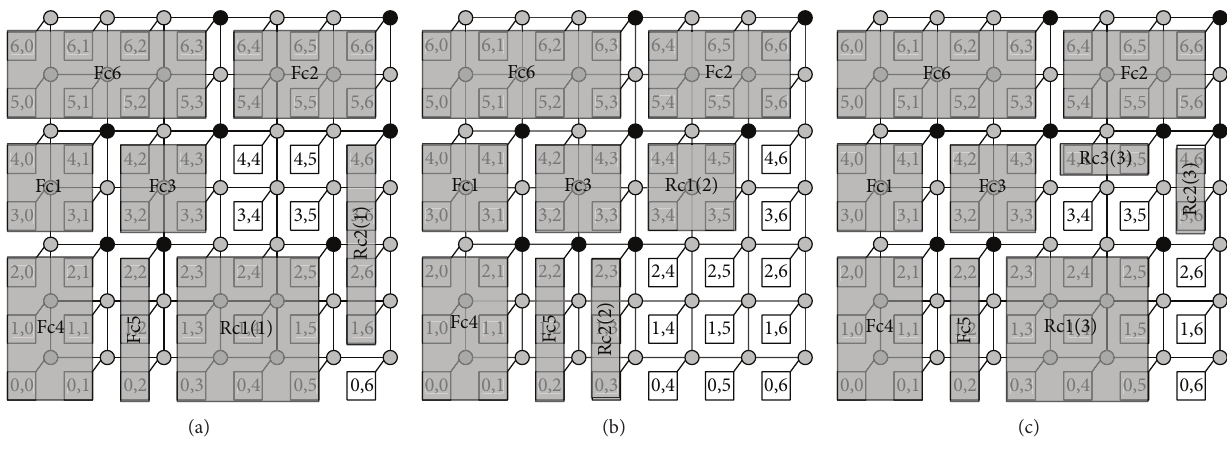
Figure 5: Mapping result for Big Alpha application: (a) scenario 1, (b) scenario 2, and (c) scenario